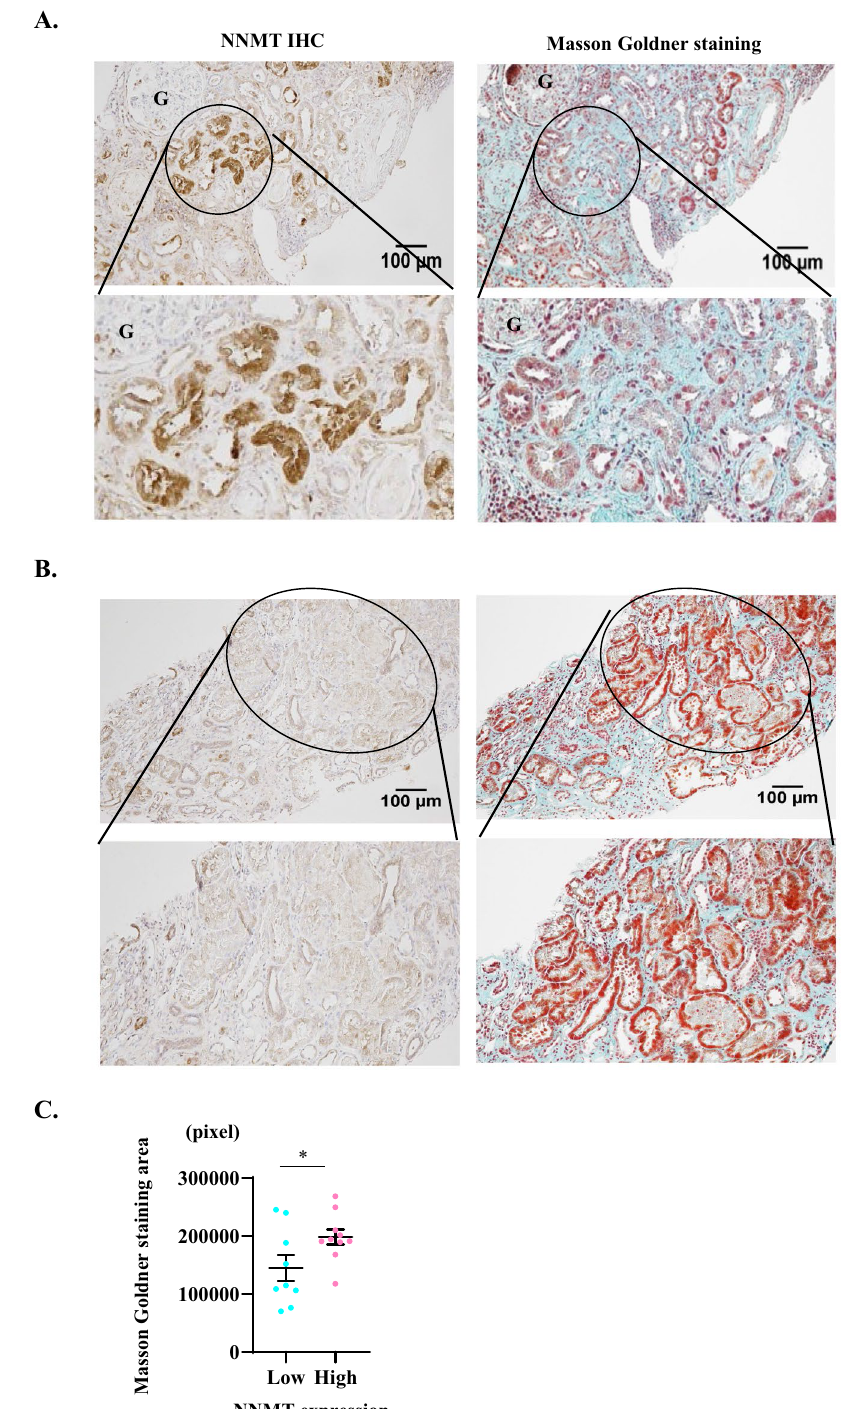
Figure 7. NNMT expression correlates with renal fibrosis in human kidney tissues. Representative image including a region with high NNMT expression ( A ) and with low NNMT expression ( B ) in human fibrotic kidney tissue and enlarged view of the circled area (left panel). Masson Goldner staining in the same area and enlarged view of the circled area (right panel). Bars represent 100 µm. ( C ) The high NNMT expression group ( n = 10) is significantly associated with renal fibrosis measured by the blue area of Masson Goldner staining, compared to the low NNMT expression group ( n = 9). NNMT, nicotinamide N-methyltransferase; IHC; immunohistochemistry. * P < 0.05 versus low NNMT expression